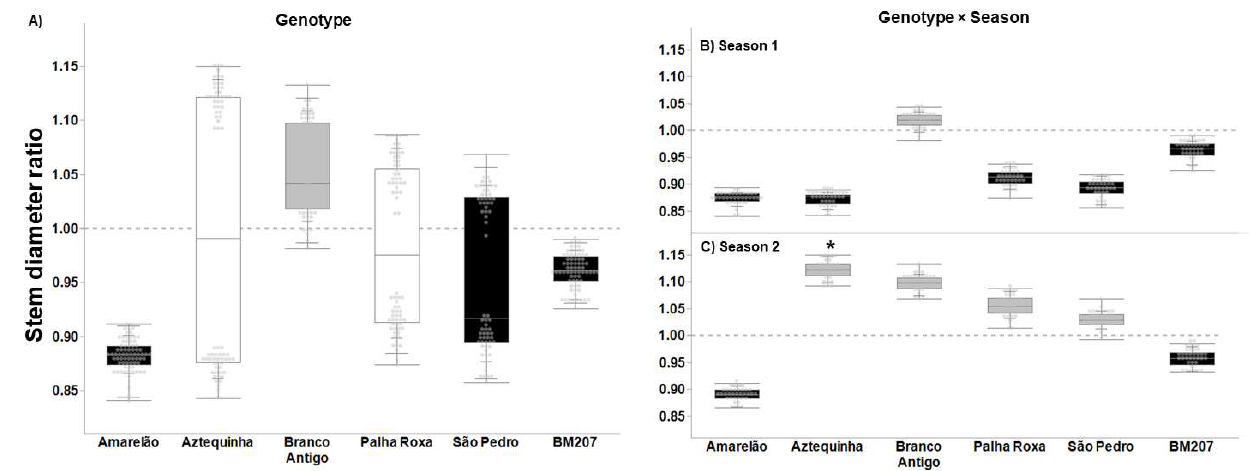
Figure 1. Tolerance ratio to FAW (= plant without insecticide application/average of plants with insecticide application) based on the growth parameter plant height in six maize genotypes ( A ), six genotypes in season 1 ( B ), and six genotypes in season 2 ( C ). In each plot, asterisks indicate statistical difference relative to BM207, per Dunnett’s test ( A ), and per a priori contrasts ( B , C ) with critical p ≤ 0.010 per Sidak’s correction. In each plot, black-filled boxes indicate non-tolerance (undercompensation, ratio < 1), and gray-filled boxes indicate tolerance (overcompensation, ratio > 1) (critical p = 0.014 per Bonferroni correction).